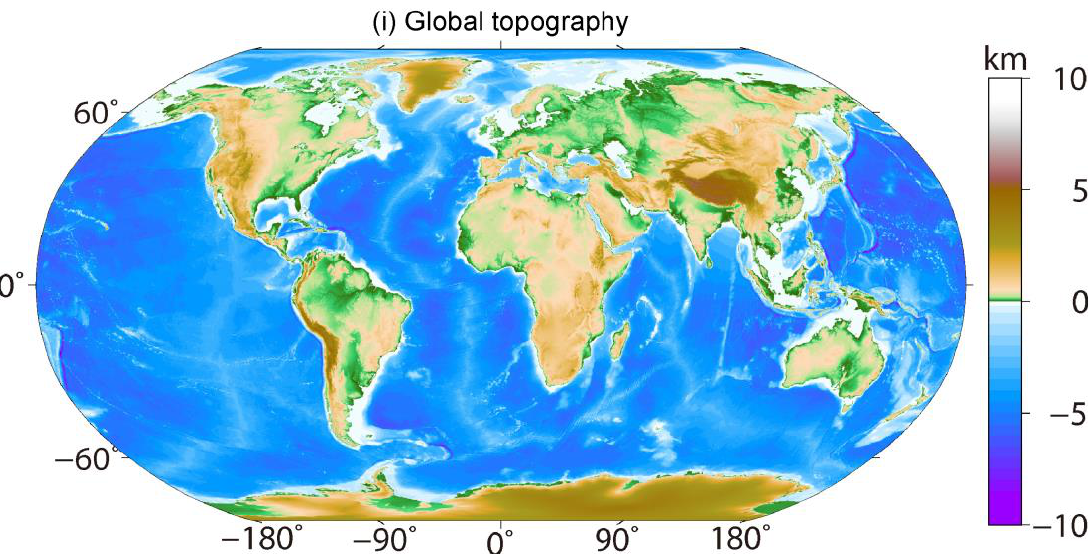
Figure 6. Distribution for the 5° elevation angle MAE and global topography. ( a , b ) are the MAE distributions for the mapping functions from the GPT3 and WTM models. ( c ) denotes the MAE difference distributions between ( a ) and ( b ). ( d ) shows the histogram of ( c ). ( e , f ) are the MAE distribution for the horizontal gradients from the GPT3 and WTM models. ( g ) is the MAE difference distribution between ( e ) and ( f ). ( h ) represents the histogram of ( g ). ( i ) shows the global topography distribution.